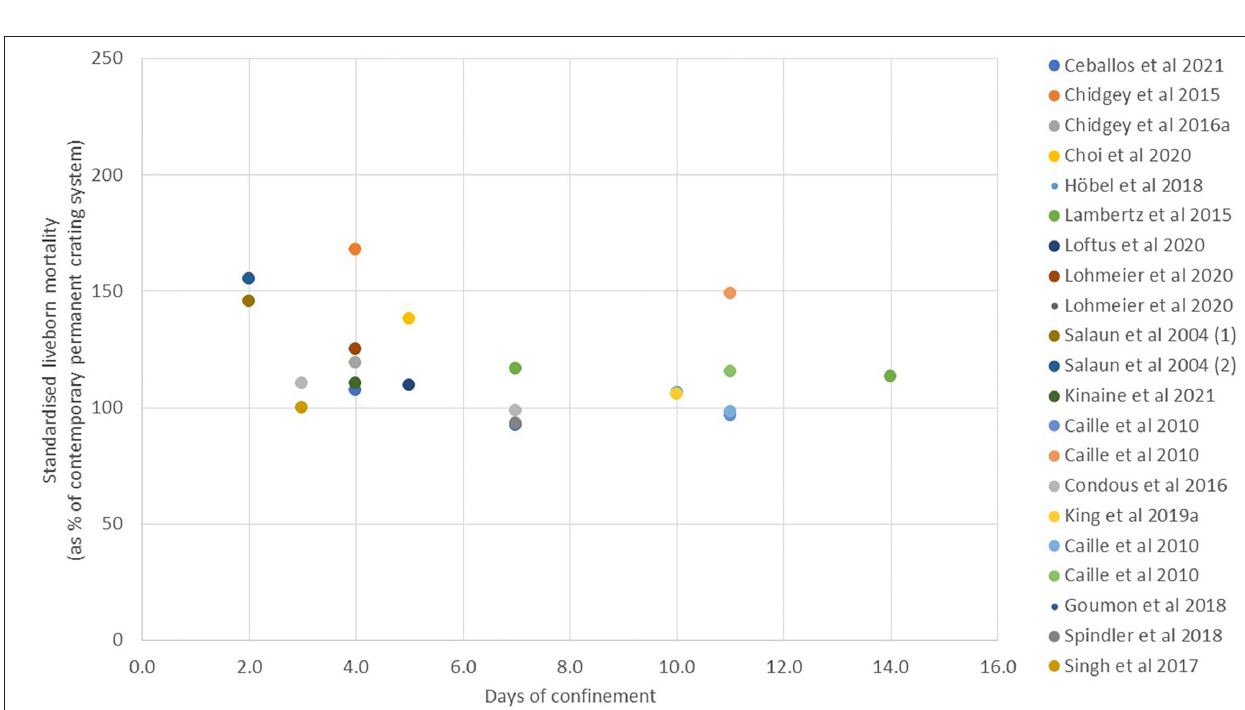
FIGURE 2 | Liveborn mortality in temporary crating systems from birth to weaning compared to systems with zero confinement (values are given as the reported mean for temporary crating when expressed as a % of the contemporary zero-confinement treatment).